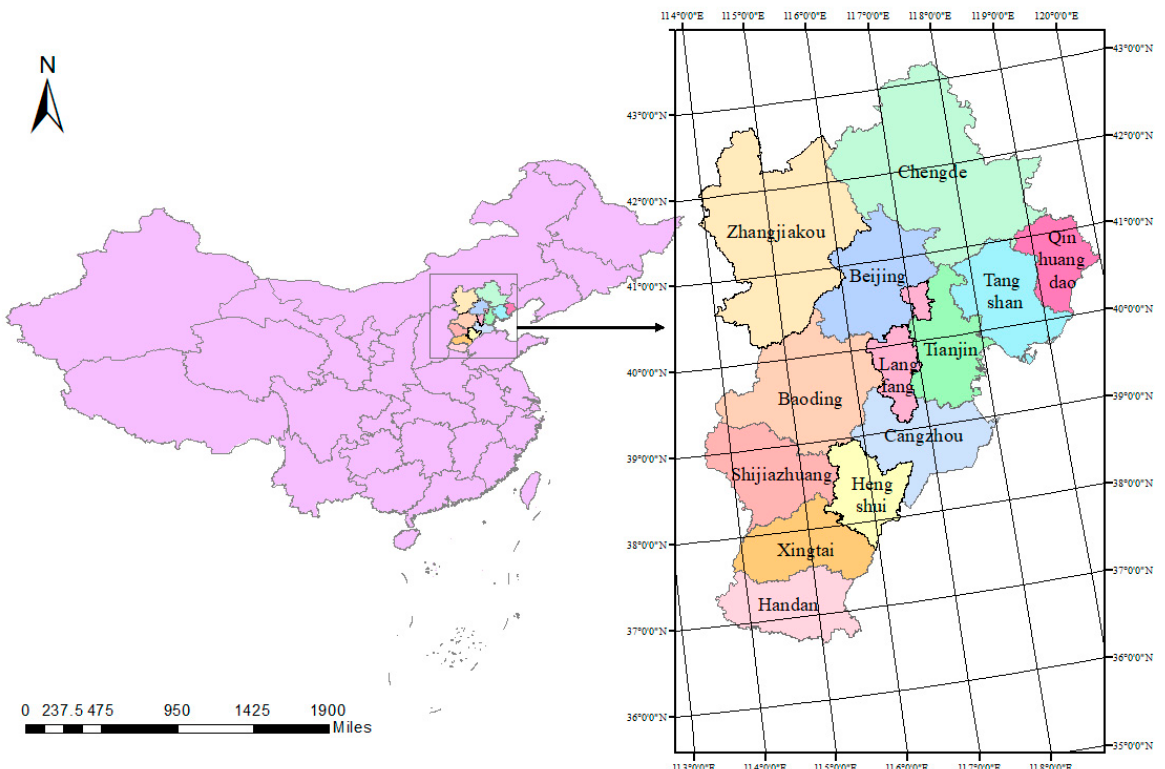
Figure 1. The geographical location of the Beijing-Tianjin-Hebei. (Refer to the map of the People’s Republic of China in http://www.gov.cn, accessed on 1 May 2022).